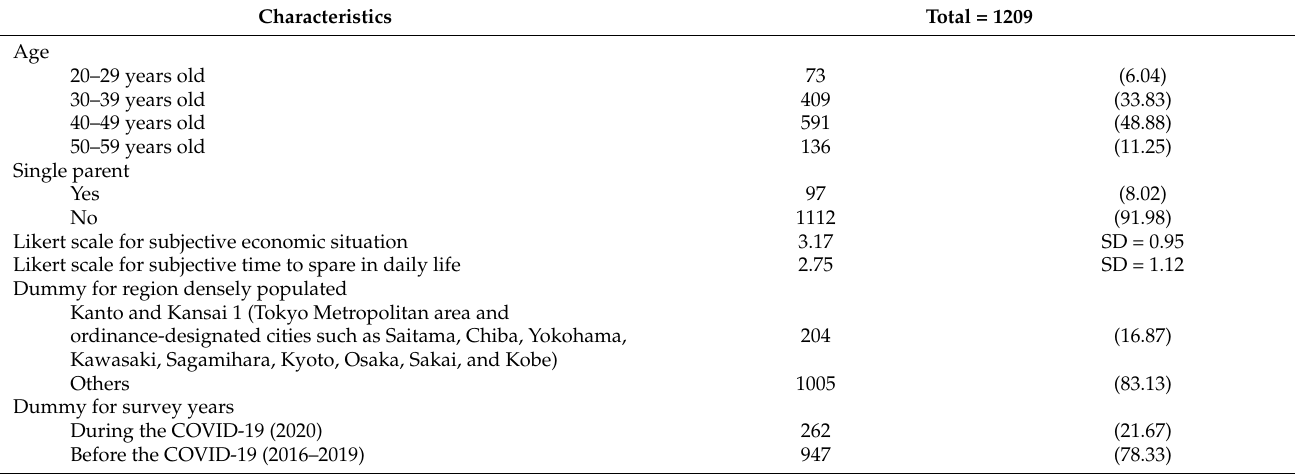
Table 1. Subject